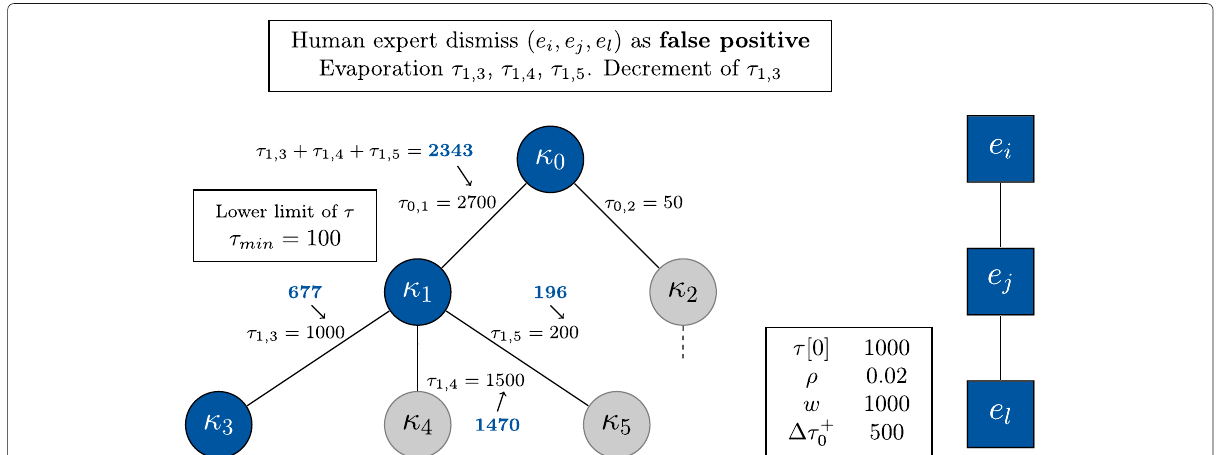
Fig. 9 Example of pheromone evolution if the attack hypothesis is refused. Parameters are in Table 2